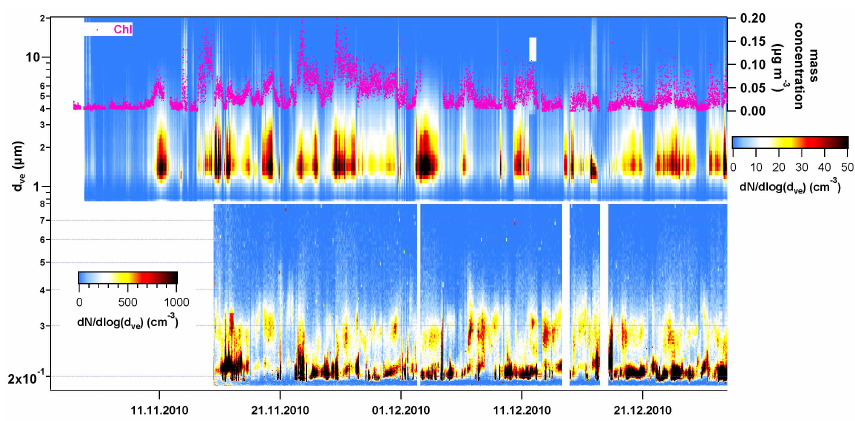
Fig. 4. Time series of SMPS (bottom) and APS (top) number size distribution measurements in d N /dlog( d ve ) . In the upper panel also the time series of particulate chloride is